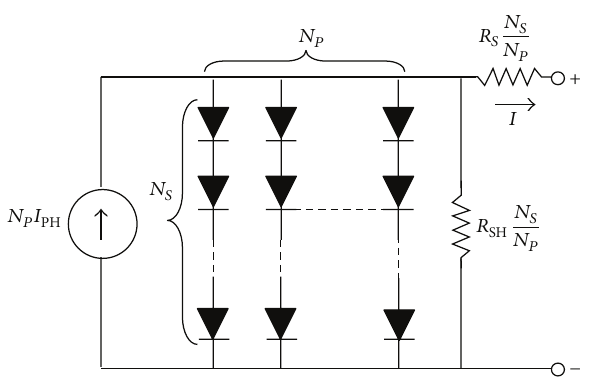
Figure 2: The general model for solar PV